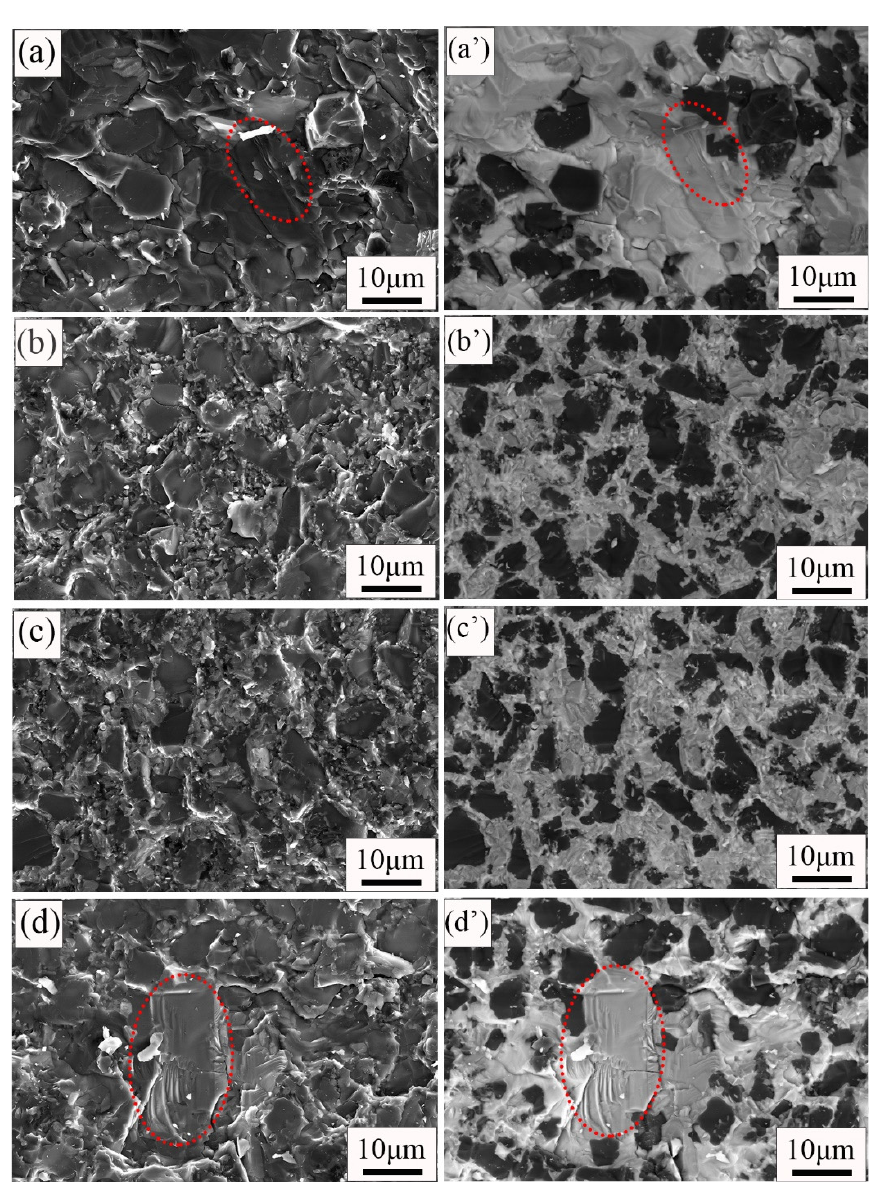
Figure 7. SEM images of RBBC composites with different carbon content additions. ( a – d ) are sec- ondary electronic diagrams; ( a ′ – d ′ ) are backscattered electron